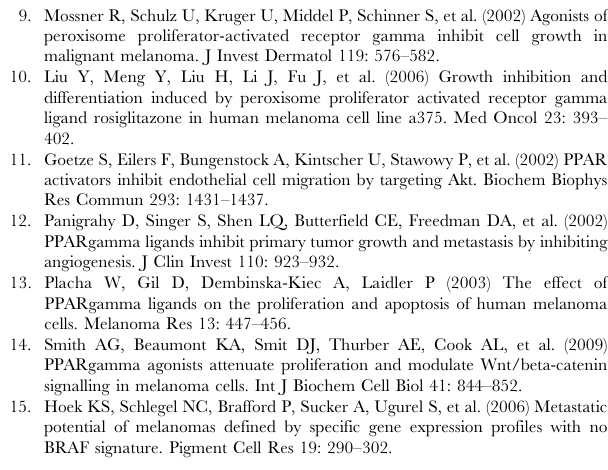
Figure S1 Representative immunoblots of three inde- pendent experiments of MMS2, MSH3, MSH6, MSH2, MLH1, Basigin and nodal after 48 hours treatment of 15d-PGJ2 with indicated concentrations (all concentra- tions are in m M). Table S1 15d-PGJ2 is superior to other PPAR ligands in inhibiting growth of melanoma cell lines, endothelial cells and of tumor associated fibroblasts superior to normal fibroblasts. Cell viability and proliferation assay. The IC50 is calculated of three independent experiments. IC50 of